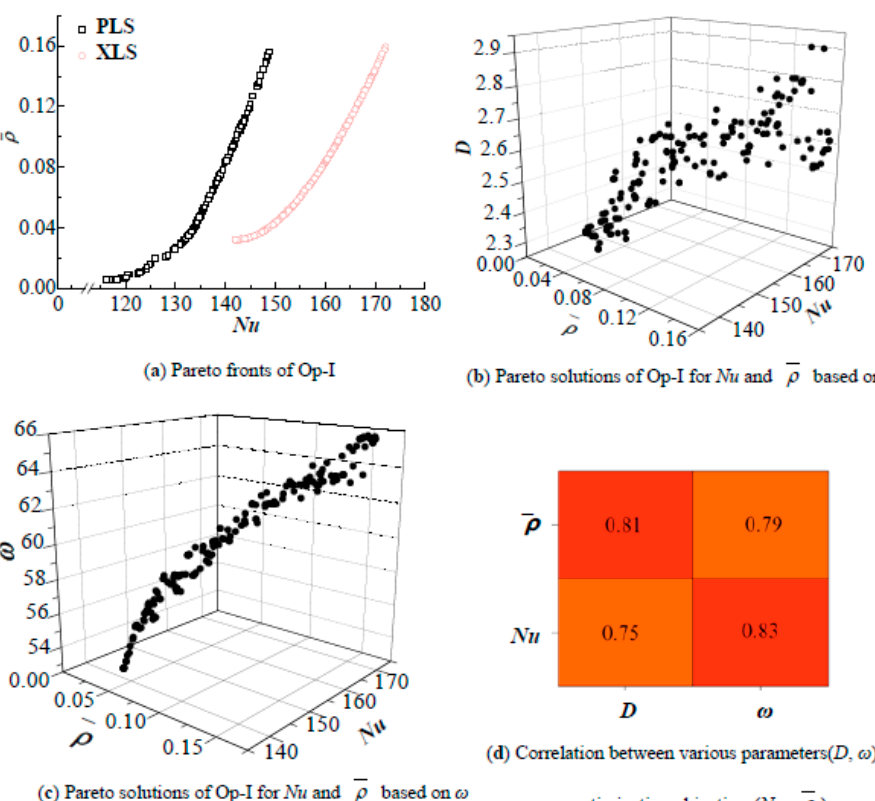
Figure 8. Overall and single sensitivity analysis for Op-I of XLS: ( a ) Pareto fronts of Op-I; ( b ) Pareto solutions of Op-I for Nu and ρ based on D ; ( c ) Pareto solutions of Op-I for Nu and ρ based on ω ; and ( d ) correlation between various parameters ( D , ω ) and optimization objectives ( Nu , ρ ).